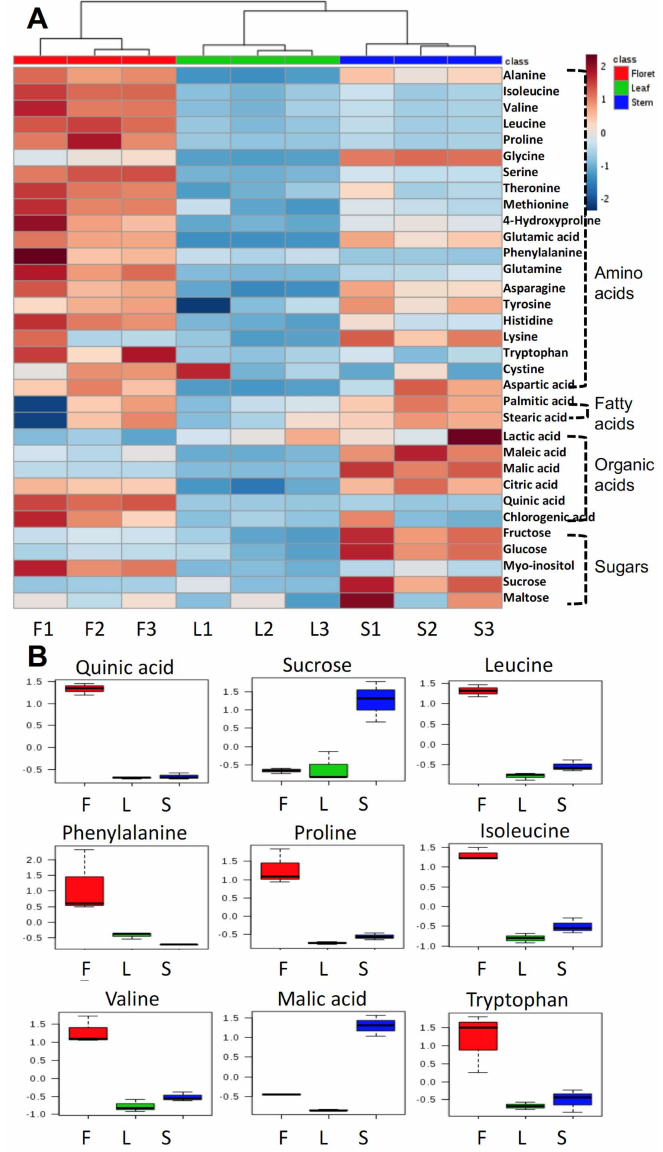
Figure 2. Primary metabolites in different tissues of broccoli (amino acids, fatty acids, organic acids, and sugars) in heatmap ( A ) and the top nine selected biomarkers based on variable importance in projections ( B ); F, L, and S indicate floret, leaf, and stem, respectively. The number after each tissue code (F, L, or S) indicates biological